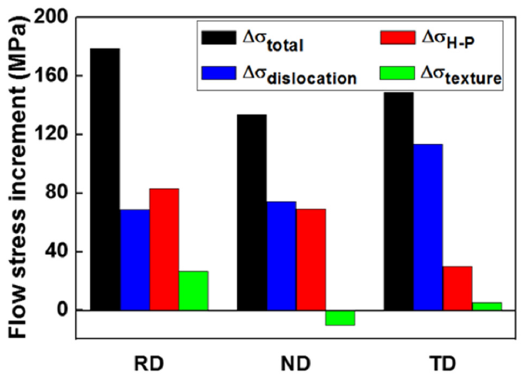
Figure 6. Contribution of stress components to the flow stress increment at a compressive strain of 0.2 based on the constitutive